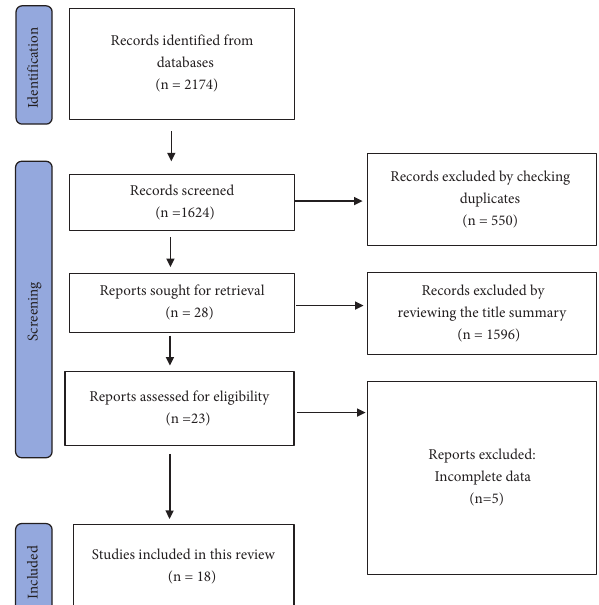
Figure 1: Flow diagram of study selection.